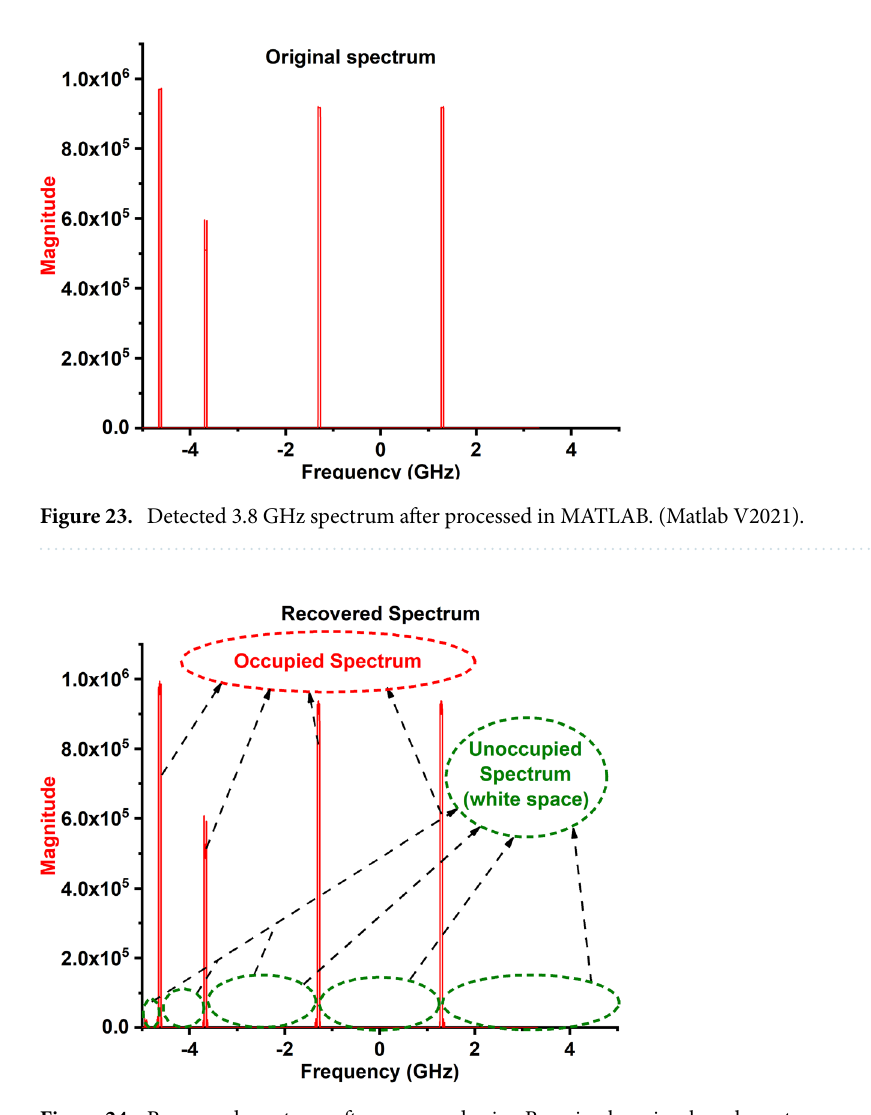
Figure 24. Recovered spectrum after processed using Bayesian learning-based spectrum sensing algorithm in MATLAB. (Matlab